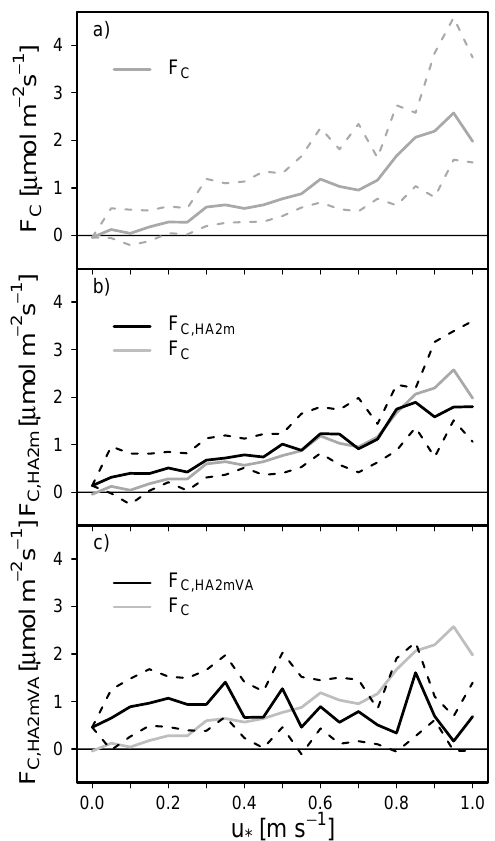
Fig. 8. Relationships of (a) night-time F C , normalized to 10 ◦ C by the temperature response function according to Lloyd & Taylor (1994), (b) F C, HA2m and (c) F C, HA2mVA to classes of friction ve- locity u ∗ for the period of May to August 2007. Black solid lines indicate the median, black broken lines the inter quantiles (25%, 75%) for the respective